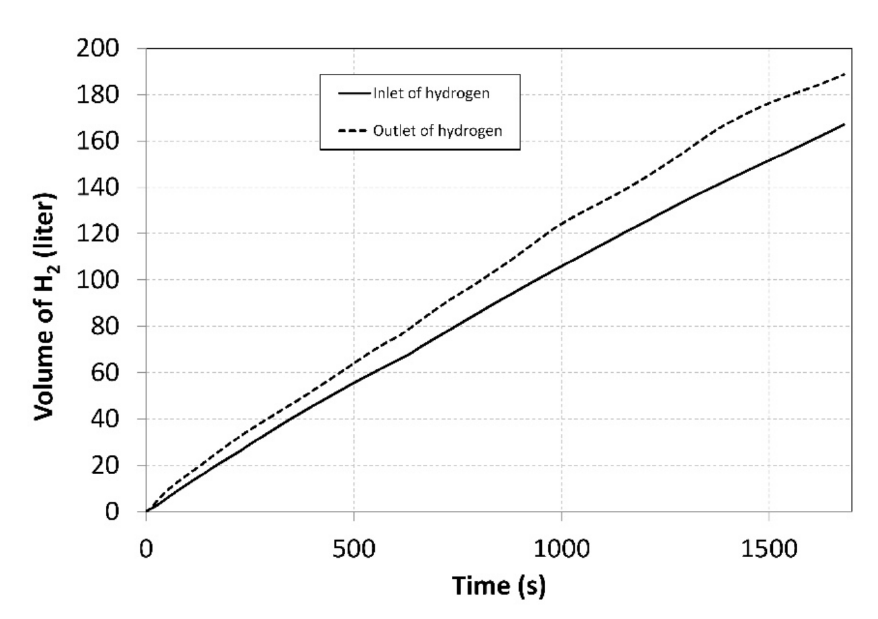
Figure 7. Total volumes of the hydrogen supplied to/removed from the compressor during measurements.